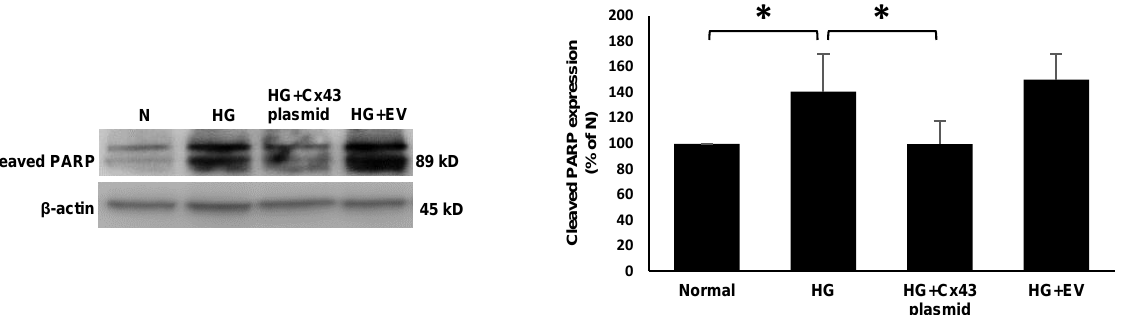
Figure 3. Cx43 overexpression reduces cleaved caspase-3 level. Cleaved caspase-3 level was significantly increased in cells grown in HG compared to those grown in N medium. In cells grown in HG and transfected with Cx43 plasmid, cleaved caspase-3 level was significantly reduced compared to those grown in HG medium. Bar graph shows cumulative data obtained from six experiments. Data are presented as mean ± SD, * p < 0.05; n = 6.